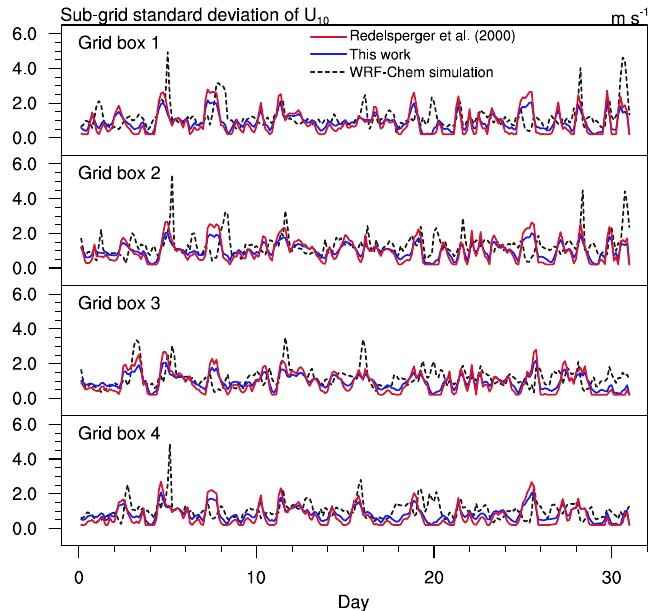
Figure 9. As in Fig. 8 but evaluating Eqs. (23) and (22) using the WRF simulation over the Southern Ocean. The domain of the WRF simulation and the location of the four imagined 225km × 225km grid cells are illustrated in Fig.